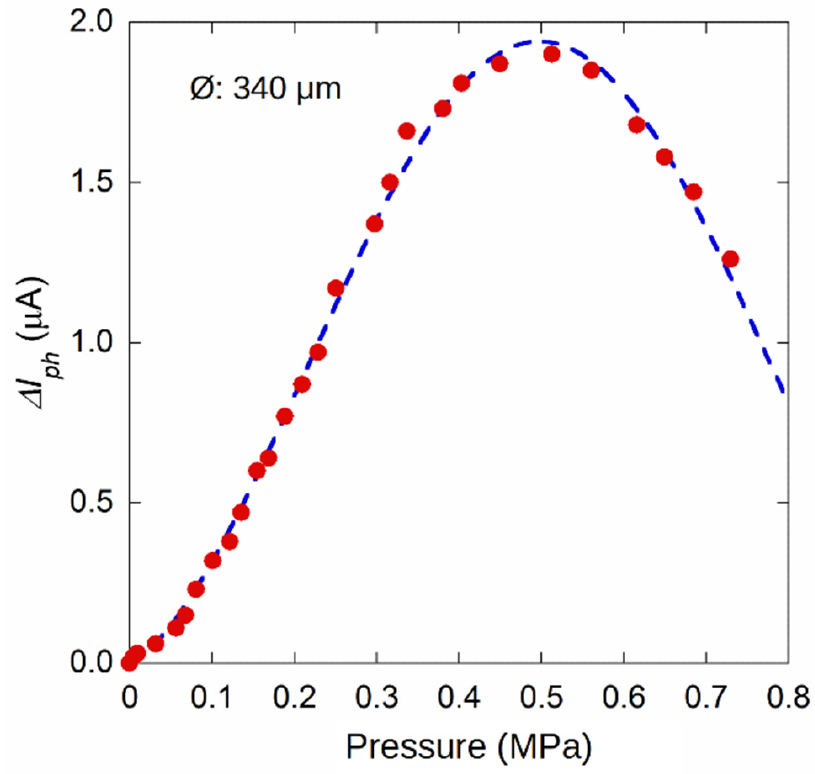
Figure 10. Photocurrent amplitude change with respect to the value acquired at p = 0 as a function of inlet pressure for a membrane sensor with a diameter around 350 µ m.